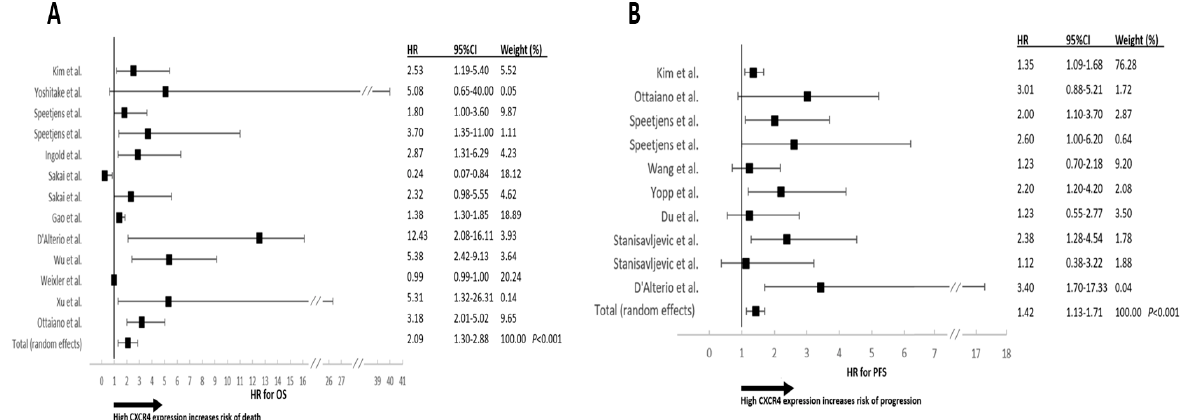
Figure 2. Funnel plots of selected studies for overall survival (OS) ( A ) and progression-free survival (PFS) ( B ).